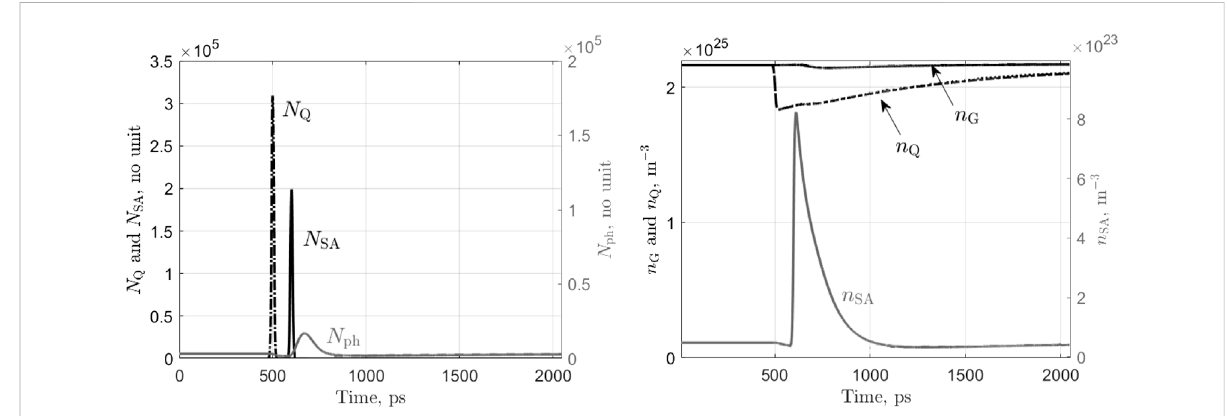
FIGURE 6 Timetracesofthephotons(left)andcarriers(right)ofthelaser-neuronunder i bias =13 mAanduponthearrivalat t =500psofaninhibitorypulse (in the GQ section) of energy 60 fJ then at 600 ps of an exitatory pulse (in the SA section) of energy 60